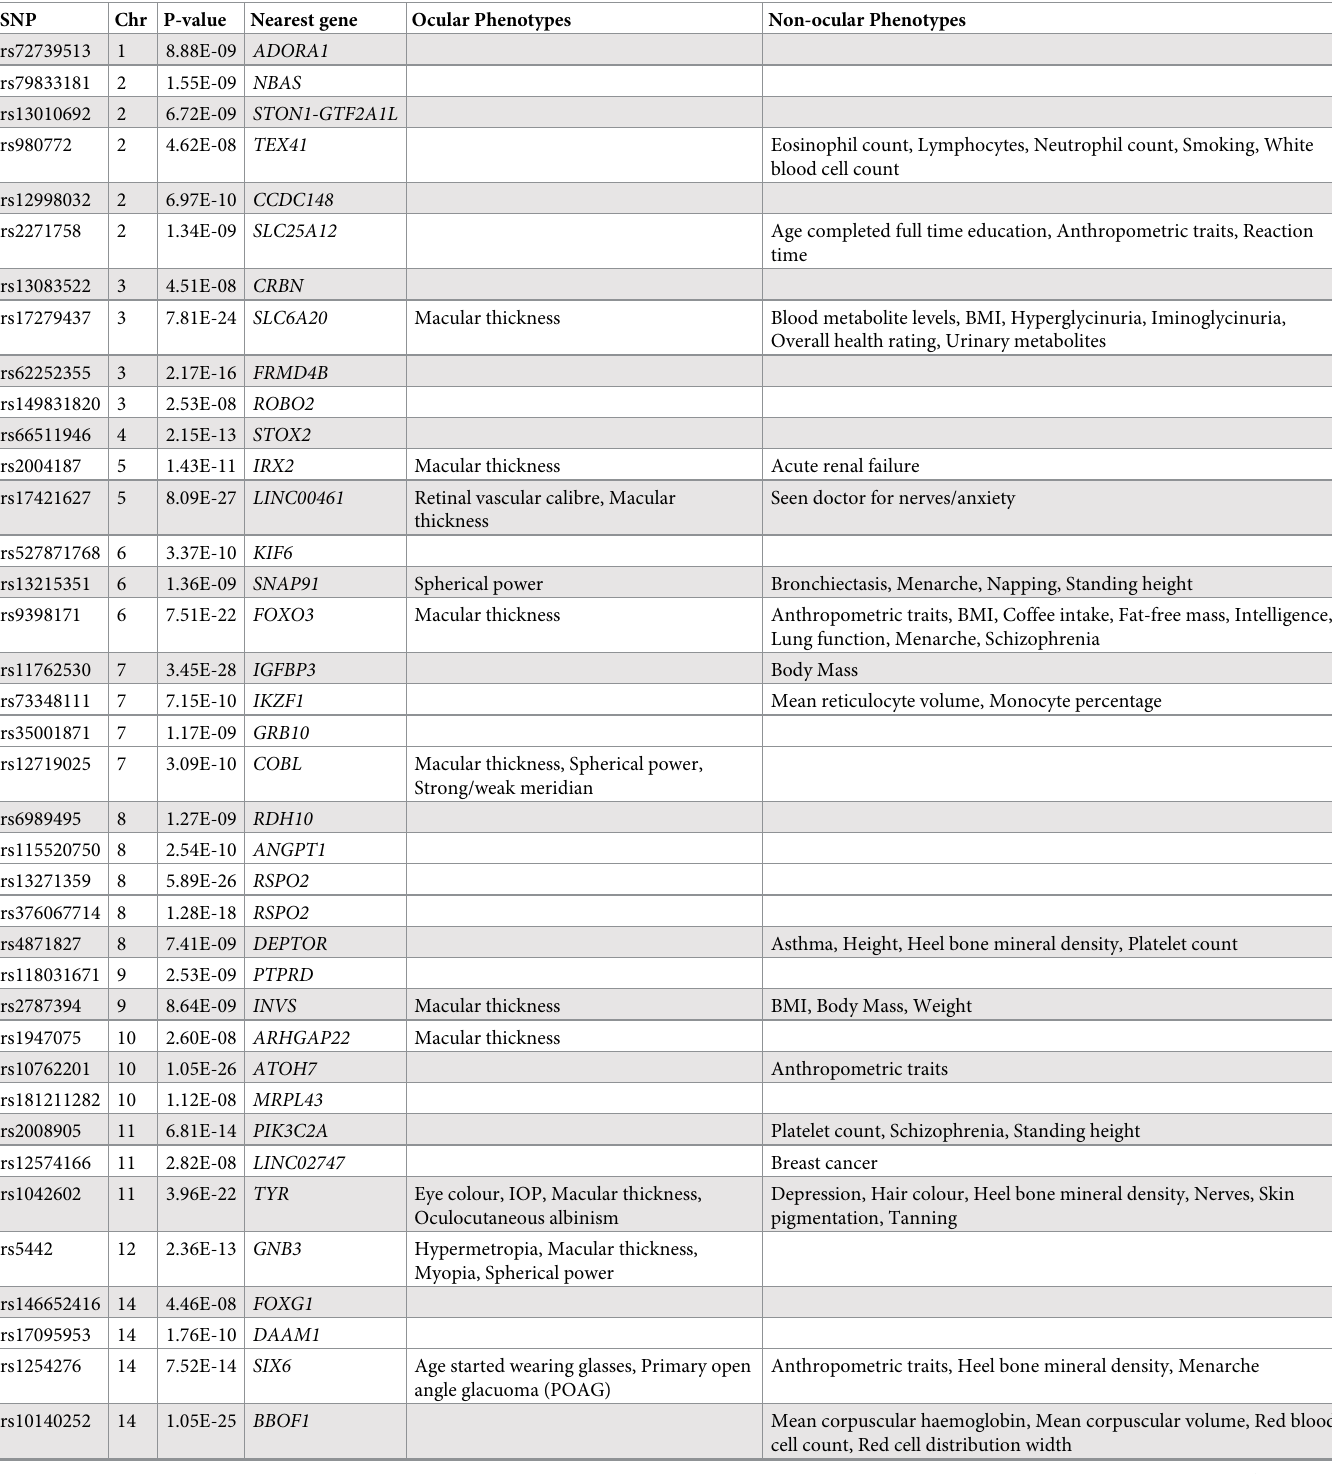
Table 1. 46 SNPs associated with GCIPL or RNFL thickness and annotations of ocular and general biology phenotypes. Variants considered to be representative of a single locus, examples of allelic heterogeneity, are highlighted in the same colour alternating white and grey. For full results including effect size, effect allele specification and standard error please see S2